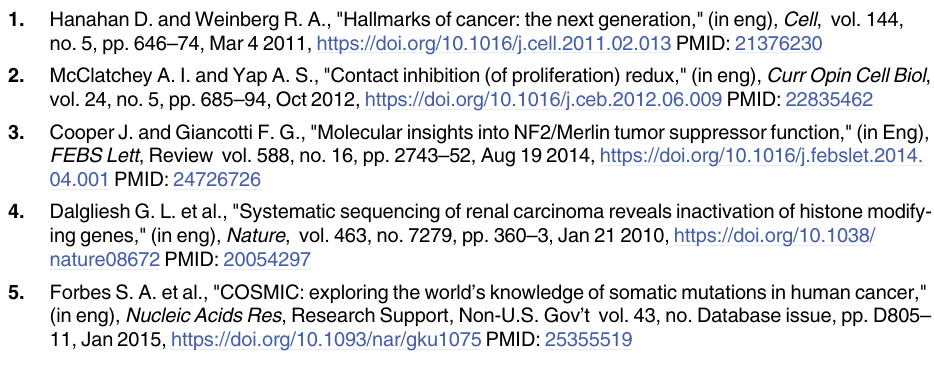
S9 Table. Genes where Pol II association is regulated by wild type vs L46R Merlin expres- sion in MDA-MB-231 by ChIP-seq. S10 Table. Genes where LEO1 association is regulated by wild type vs L46R Merlin expres- sion in MDA-MB-231 by ChIP-seq. S11 Table. Proteins identified by mass spectrometry with TAP6-CDC73, -PAF1 or–LEO1 in HT1080 or MDA-MB-231 cells. S12 Table. Proteins identified by mass spectrometry after affinity purification of TAP6-CDC73 in HEK293T cells co-expressing either Ezrin or